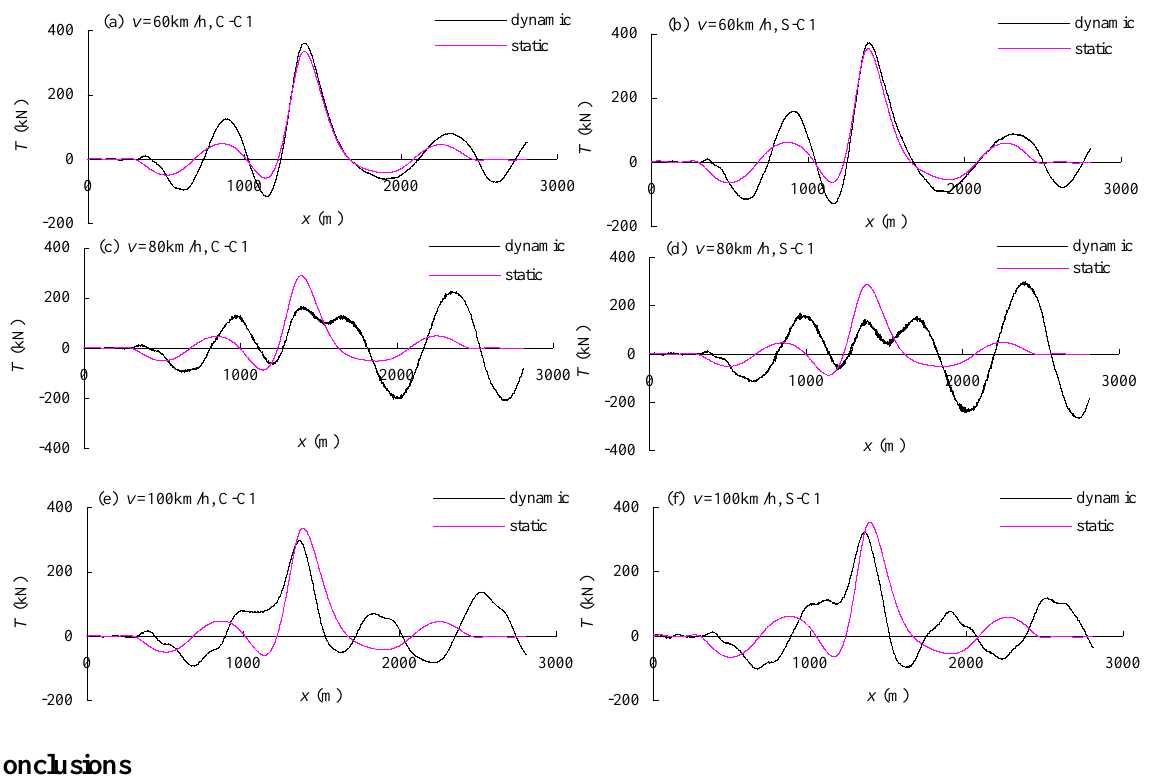
Figure 22. Static and dynamic tension responses of cables: ( a ) CFRP cable under vehicles moving at 60 km/h; ( b ) steel cable under vehicles moving at 60 km/h; ( c ) CFRP cable under vehicles moving at 80 km/h; ( d ) steel cable under vehicles moving at 80 km/h; ( e ) CFRP cable under vehicles moving at 100 km/h; ( f ) steel cable under vehicles moving at 100